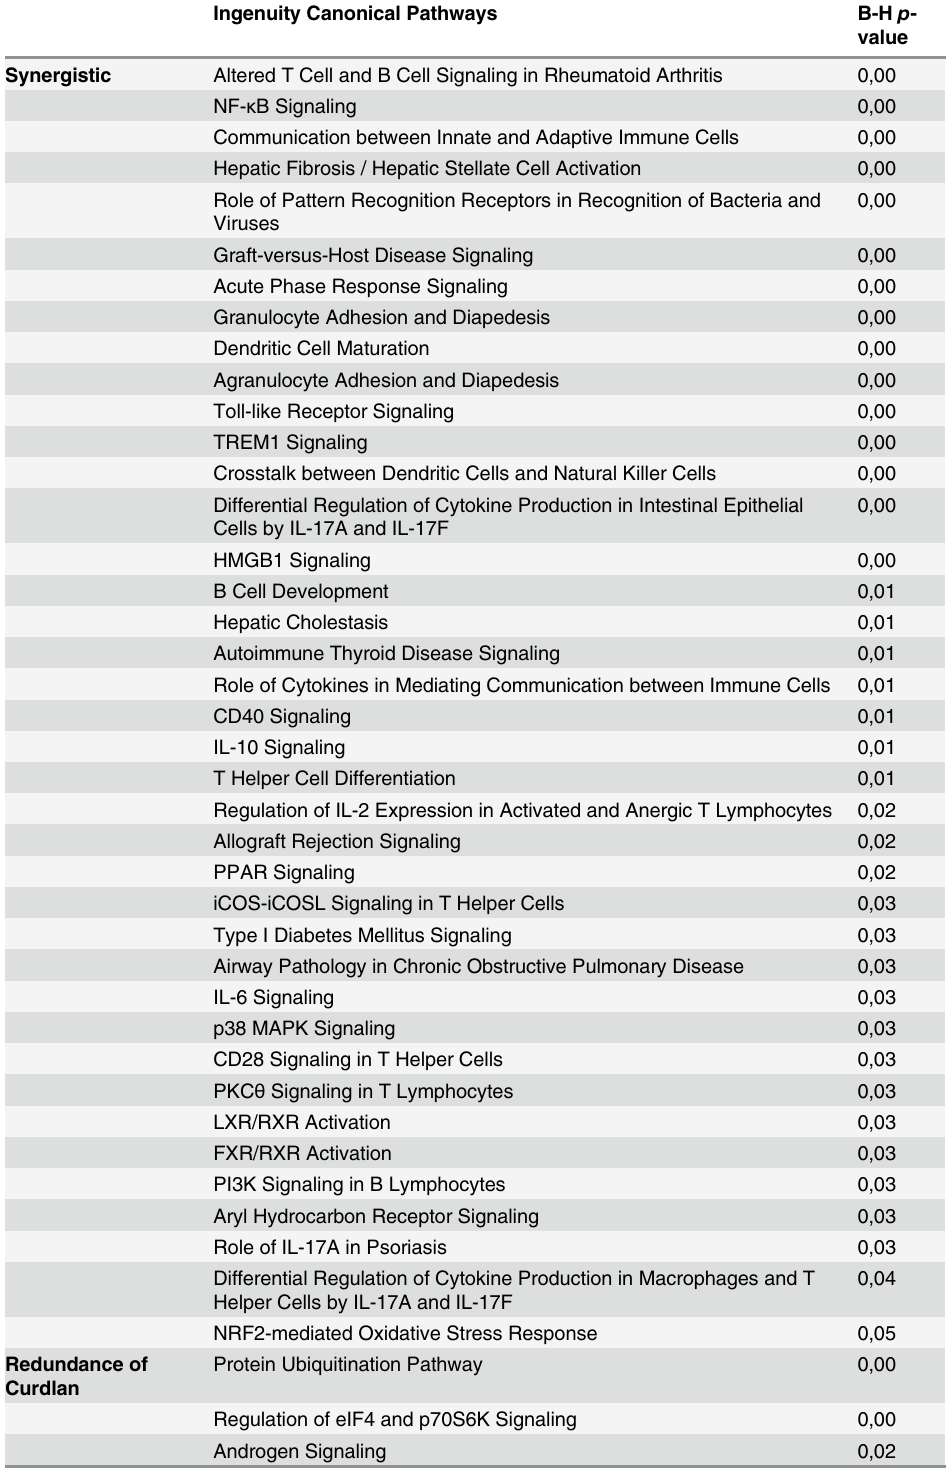
Table 7. Additional experiment with curdlan 1 μ g/ml: Canonical pathways with Benjamini-Hochberg p - value < .